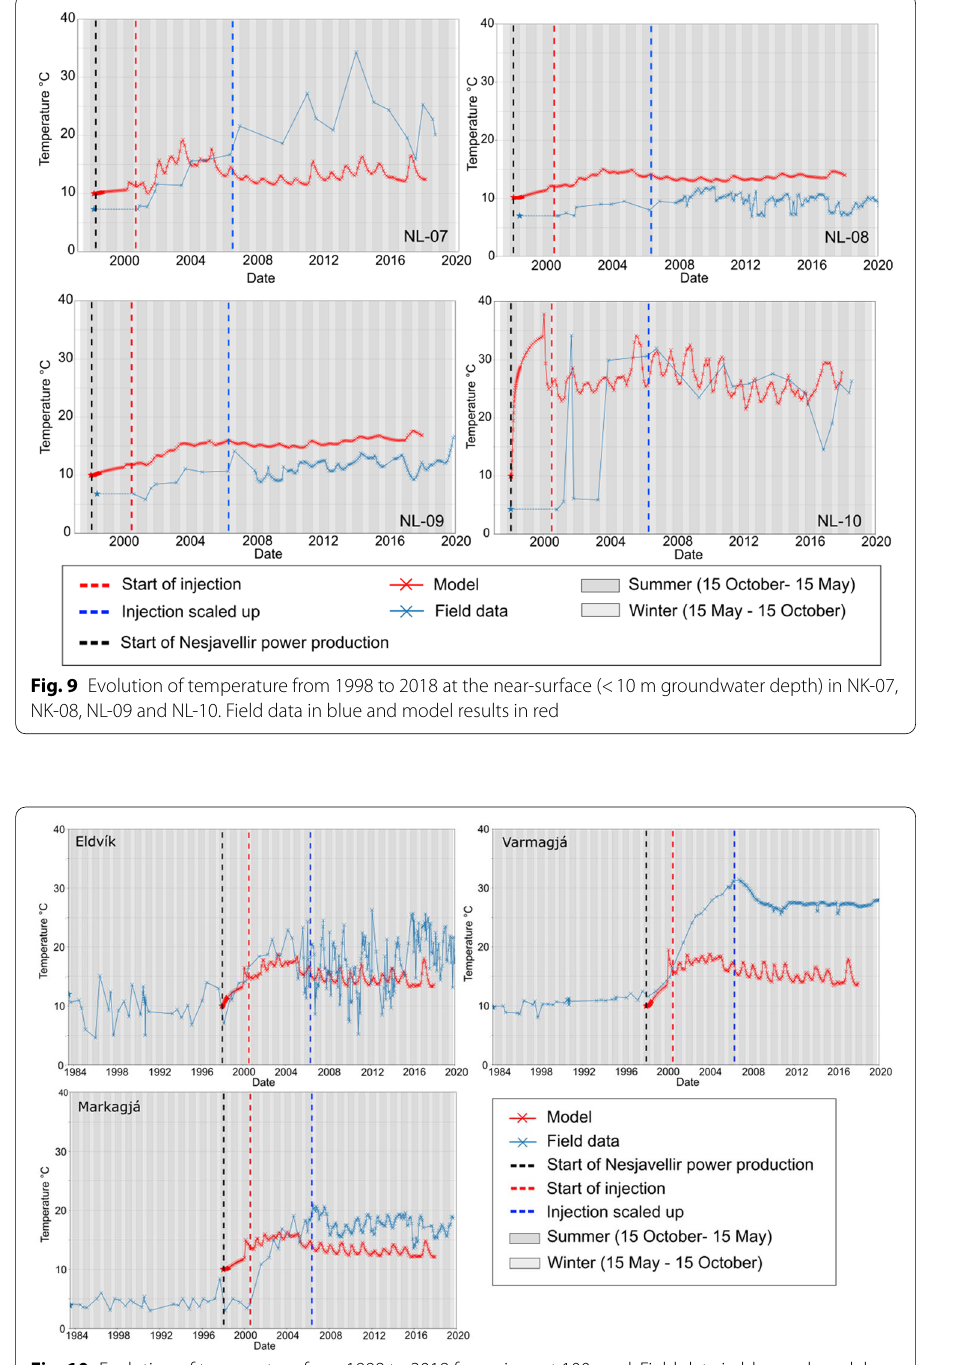
Fig. 10 Evolution of temperature from 1998 to 2018 for springs at 100 masl. Field data in blue and model results in